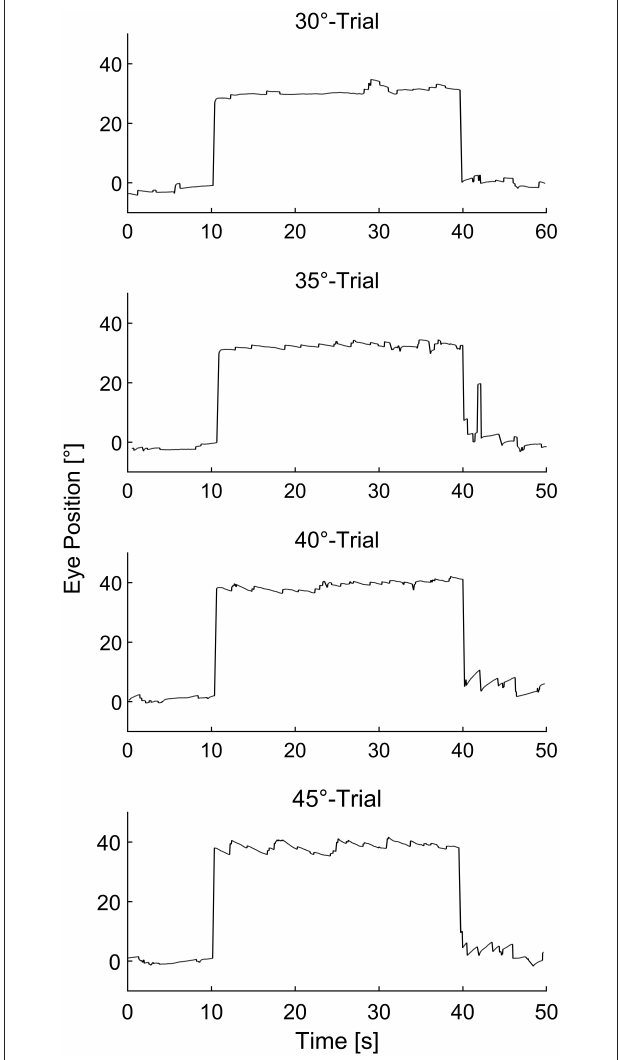
FIGURE 1 | Representative eye movement traces of a single subject before, during, and after sustained eccentric gaze at 30 ◦ , 35 ◦ , 40 ◦ , and 45 ◦ respectively.